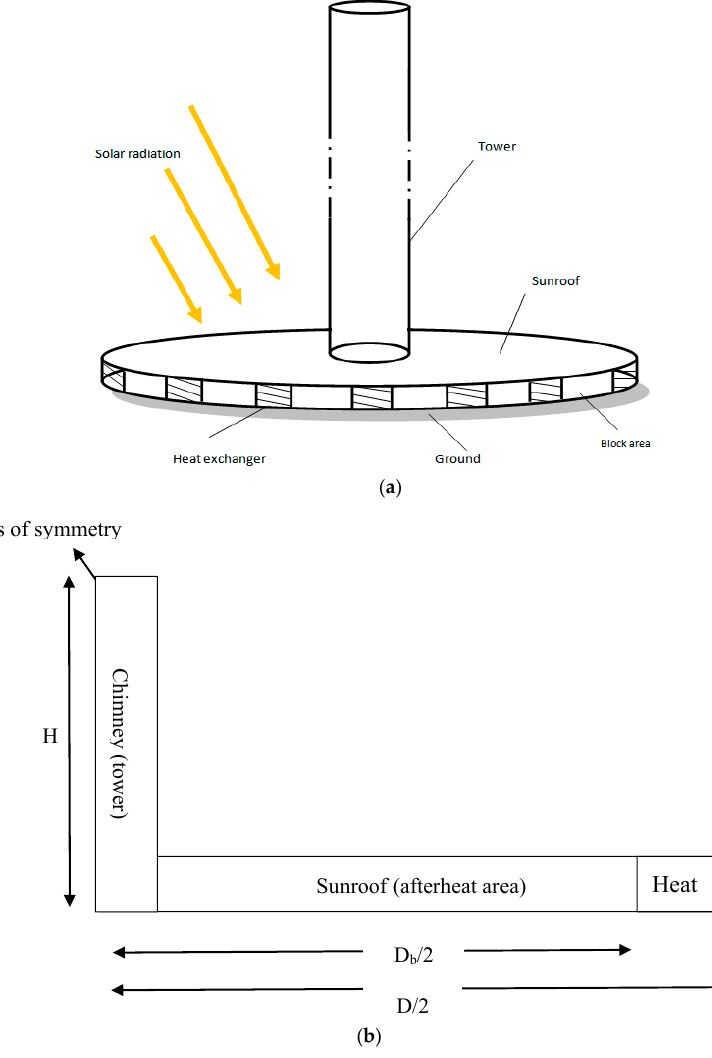
Figure 1. ( a ) The SENDDCT concept investigated by Zou [5] and ( b ) Schematic view of half of the tower (due to symmetry).